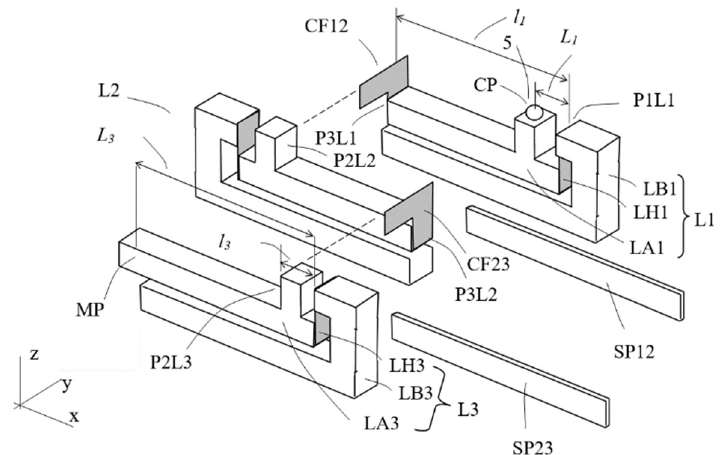
Figure 10. The conceptual design D in exploded view.